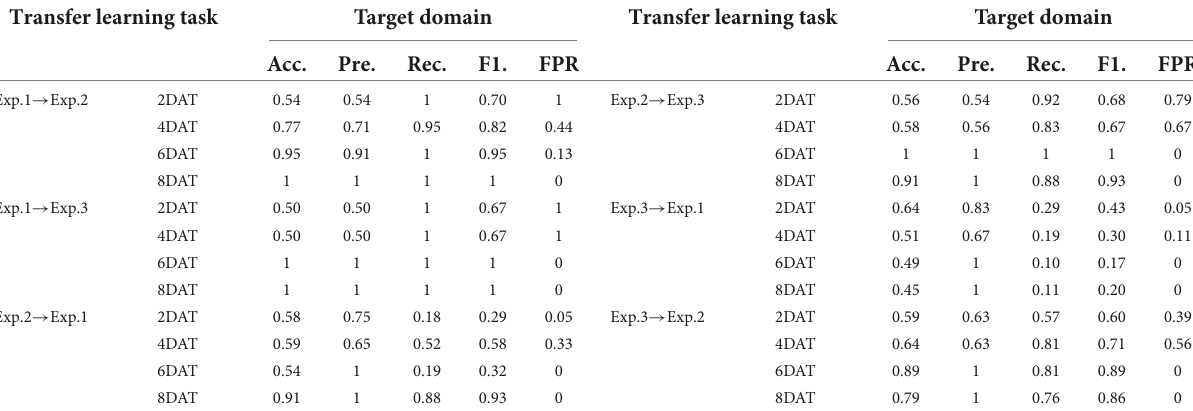
TABLE 2 Prediction results of support vector machine models on target